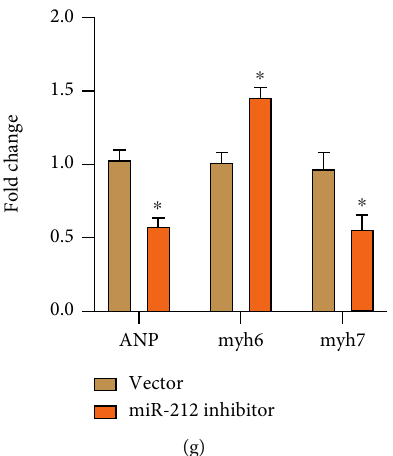
Figure 3: miR-212 promotes CH. (a) The expression of miR-212 in the control and EG groups ( “ ∗ ” indicates statistical di ff erence from the control group P < 0 : 05 ). (b) E ff ect of primary cardiac myocytes transfected with Ad-miR-212 adenovirus. (c) The expression of miR-212 in the Ad-vector and Ad-miR-212 groups ( “ ∗ ” indicates statistical di ff erence from the Ad-vector group P < 0 : 05 ). (d) The expression of ANP, myh6, and myh7 in the Ad-vector and Ad-miR-212 groups ( “ ∗ ” indicates statistical di ff erence from the Ad-vector group P < 0 : 05 ). (e) Cell immuno fl uorescence staining α -actinin in the Ad-vector and Ad-miR-212 group. (f) The expression of miR-212 in the vector and miR-212 inhibitor groups ( “ ∗ ” indicates statistical di ff erence from the vector group P < 0 : 05 ). (g) The expression of ANP, myh6, and myh7 in the vector and miR-212-inhibitor groups ( “ ∗ ” indicates statistical di ff erence from the vector group P < 0 : 05